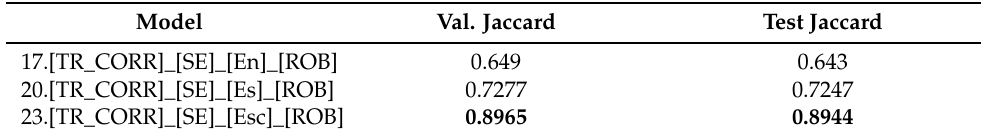
Figure 14. Jaccrad score performance evaluation of the proposed coverage model (green). Left and right plots display average scores of validation and test sets respectively. Shaded area is the standard deviation of 5 models. Model 17 (pink, with no additional meta data) performs least but Models 20 (magenta) and 23 (green) demonstrate impressive performance improvements with meta information. Table 9. Coverage-based subsentence extraction results